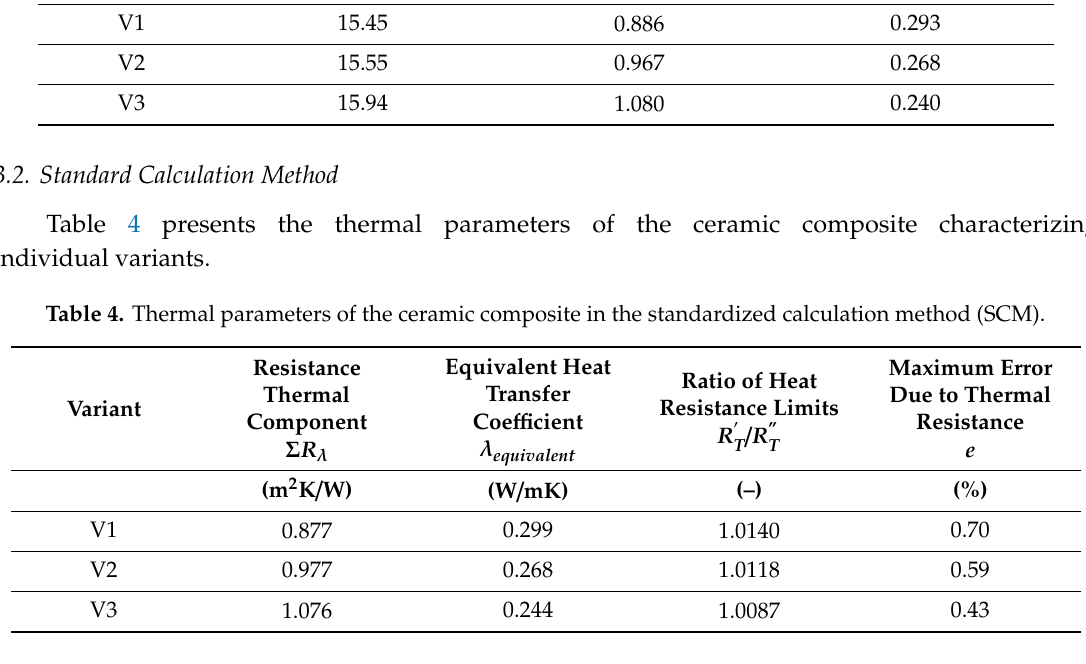
Table 3. Thermal parameters of the ceramic composite in the experimental method (EM). Gradient Resistance Temperature on the Thermal Component Variant Surface of the Partition Σ R λ ∆ T